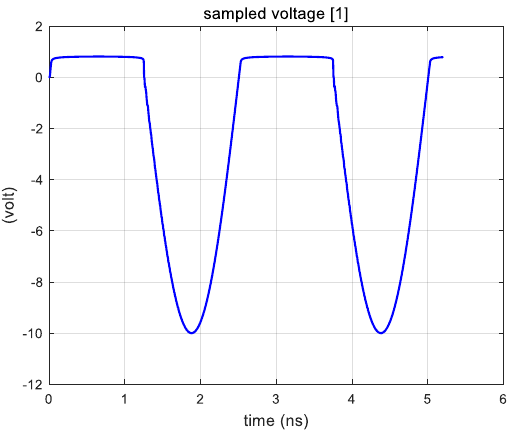
Figure 12. Results for the improved equivalent circuit method.